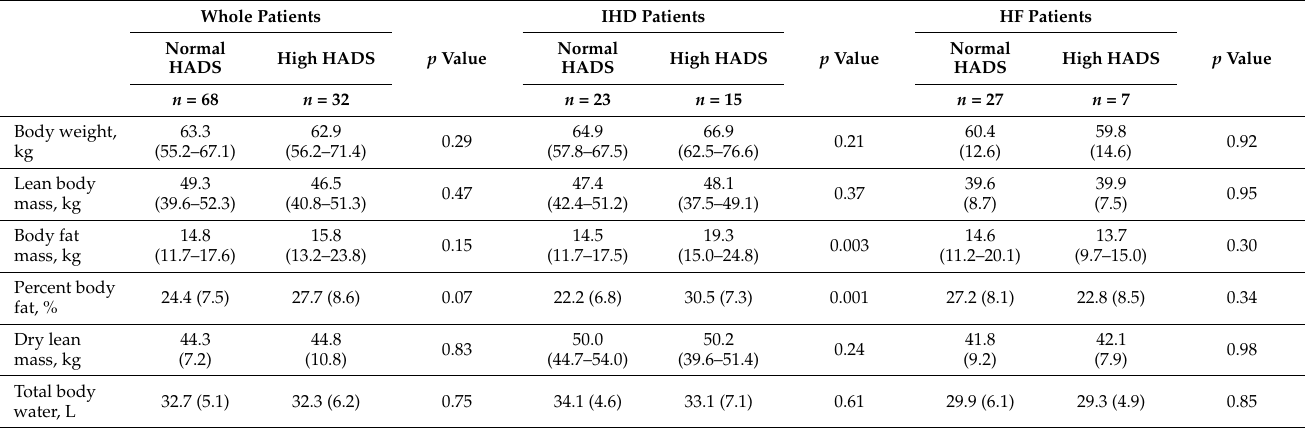
Table 2. The differences of body composition between normal HADS group and high HADS group in whole patients, IHD patients, and HF